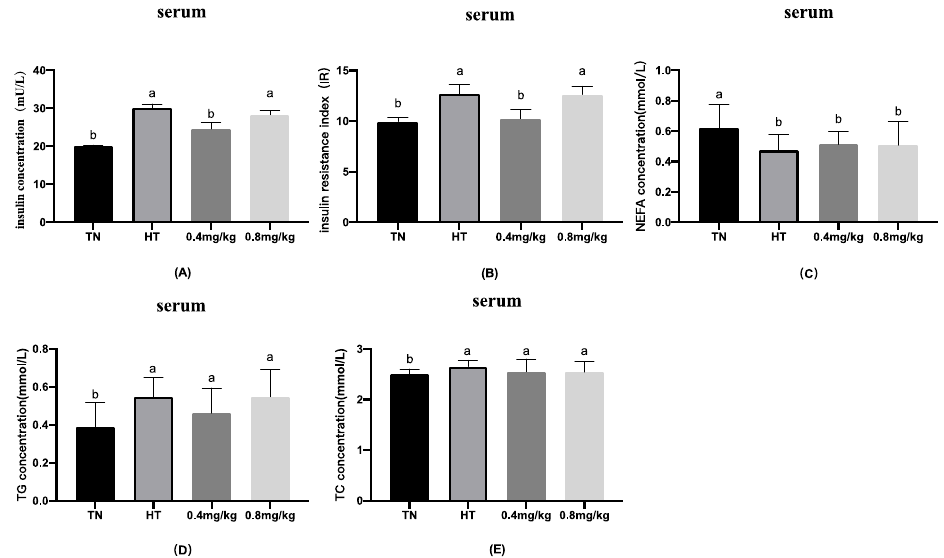
Figure 3. Effects of chromium supplementation on glucose homeostasis and other serum parameters. ( A ) Insulin concentration in the serum; ( B ) insulin resistance index in the serum; ( C ) NEFA concentration; ( D ) TG concentration in the serum; ( E ) TC concentration in the serum. a,b Means values between the column with different letters differ significantly.